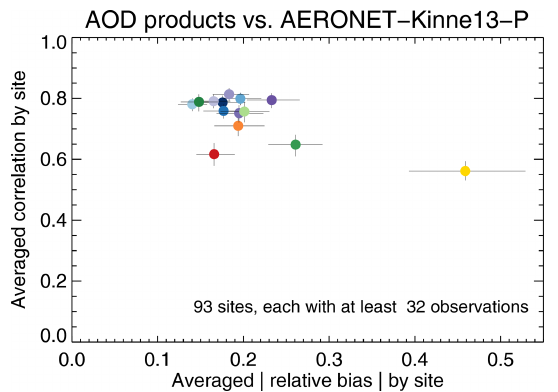
Figure 8. Evaluation of satellite products with AERONET per site, averaged over all sites. Error bars indicate the 5%–95% uncertainty range based on a bootstrap analysis of sample size 1000. Colours indicate the satellite product; see also Fig. 1. Products were indi- vidually collocated with AERONET (Kinne et al., 2013, selection, pruned) within 1h. All products use the same sites, each of which produced at least 32 collocations with each